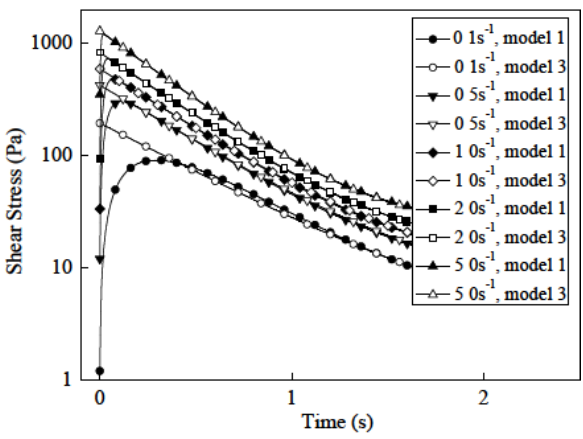
Figure 7: The comparison of description of rheological data between Model 1 and Model